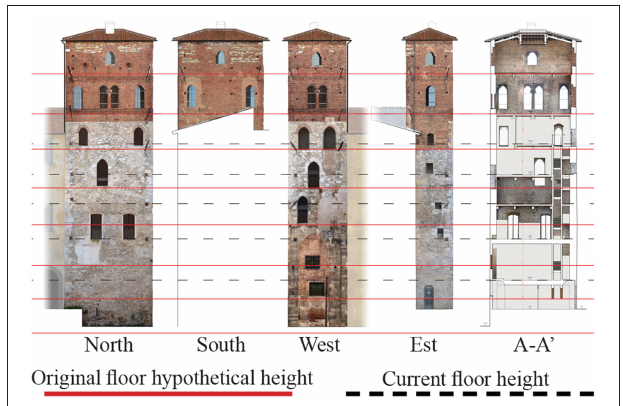
FIGURE 7 | Comparison among the actual and the original floor height of the Lanfreducci